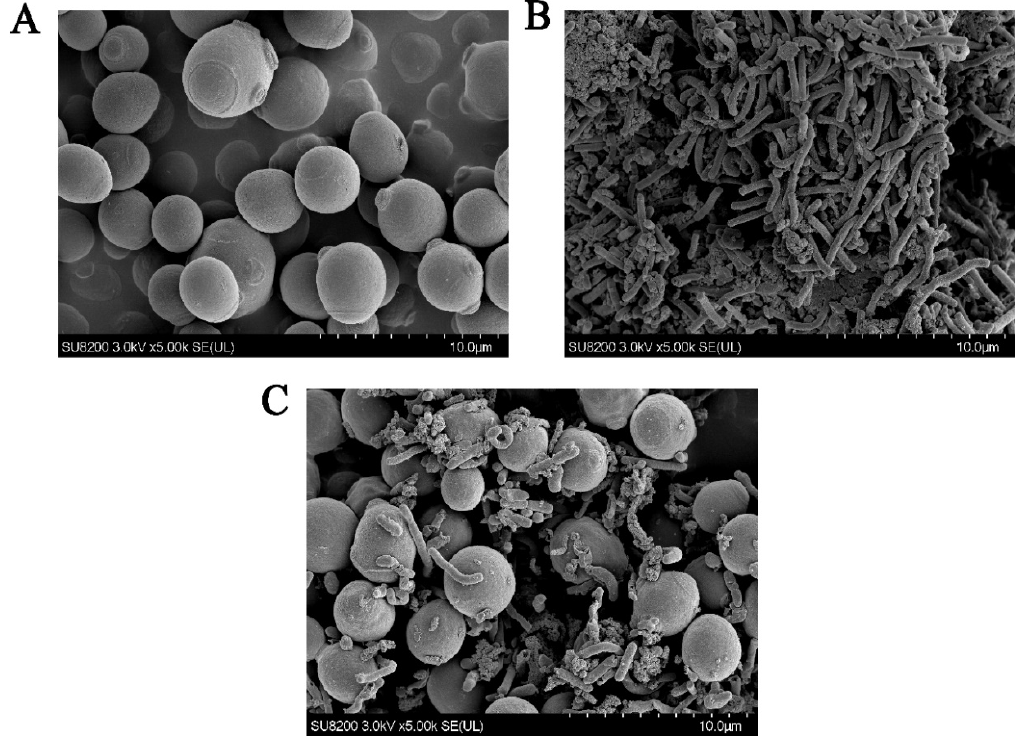
Figure 4. Cell morphology of S. cerevisiae and L. panis under different conditions observed using scanning electron microscopy in cold field. ( A ) Monoculture of S. cerevisiae and ( B ) L. panis . ( C ) Co-culture of S. cerevisiae and L. panis .